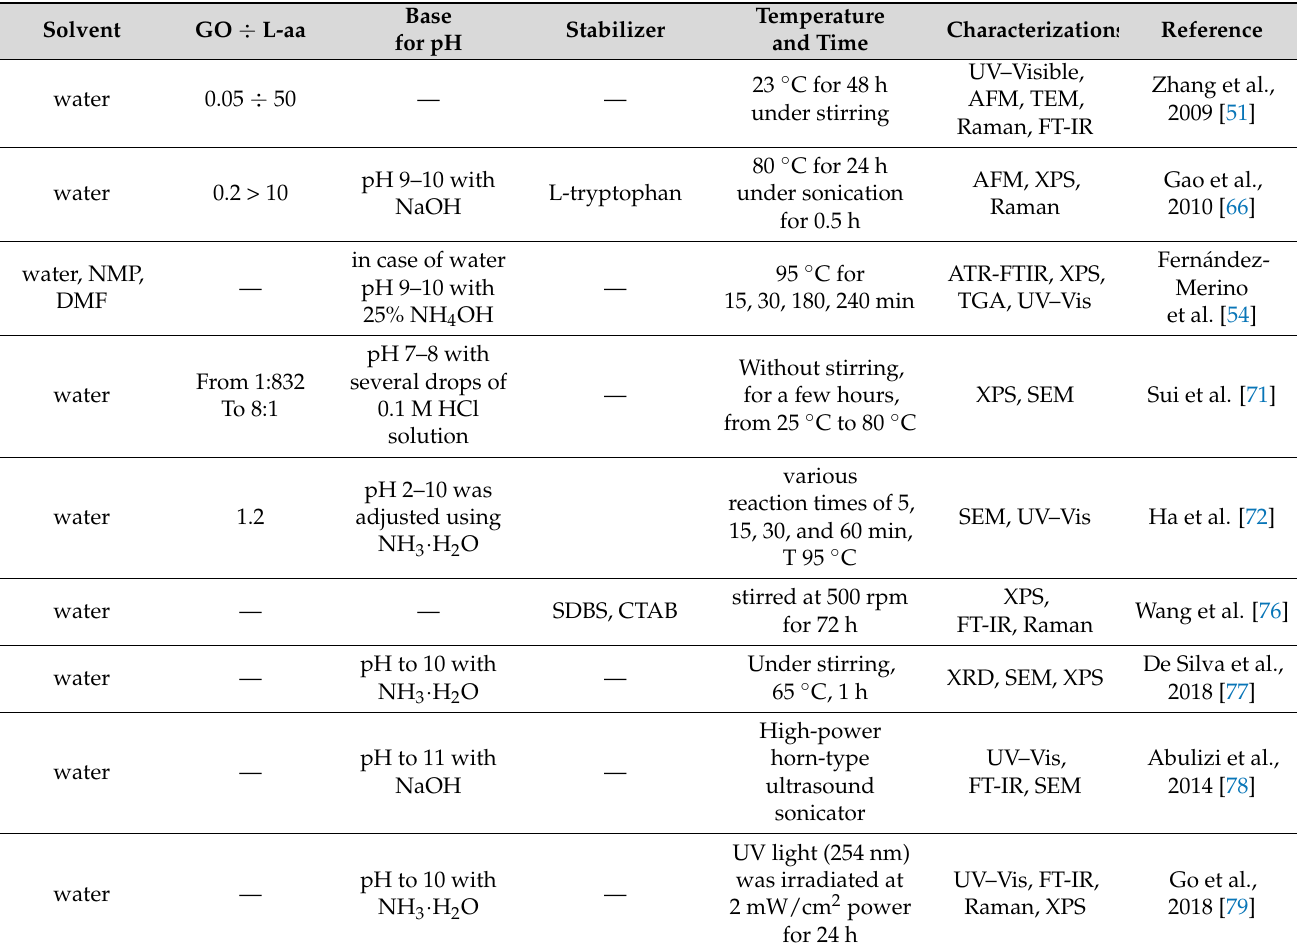
Table 1. Summary of the principal parameters used in the cited methods of the liquid-phase reduction of